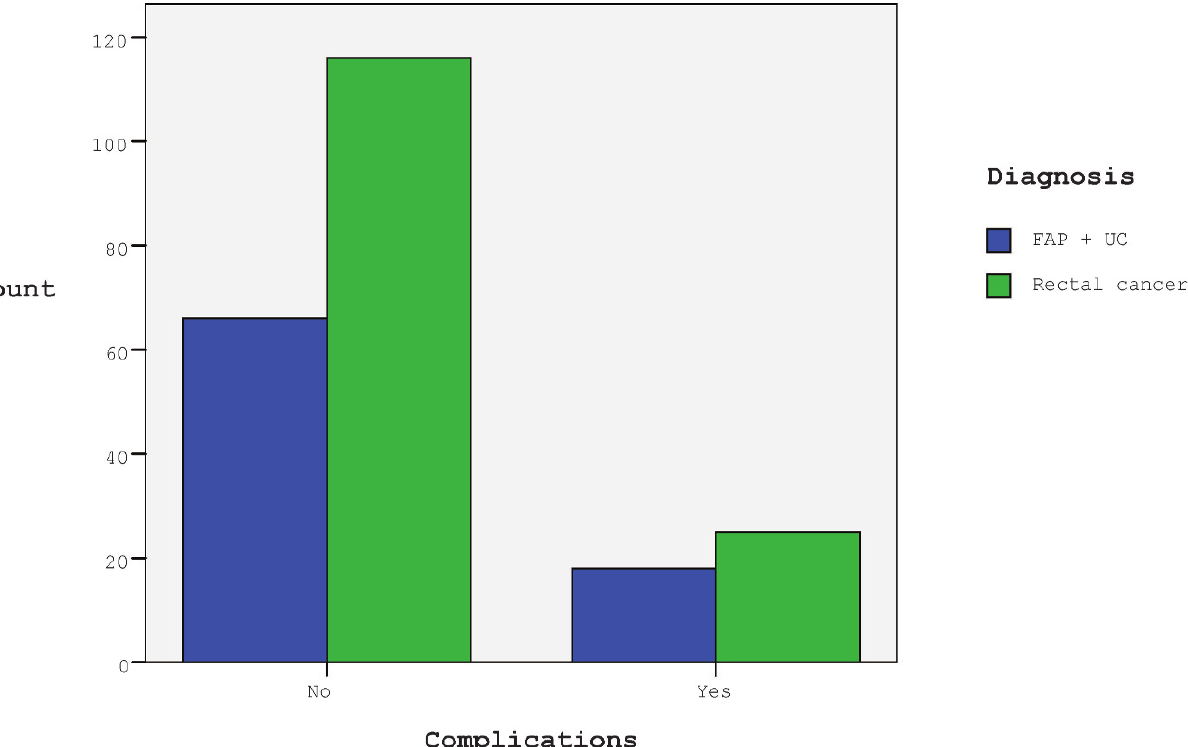
Figure 2 - A statistical analysis of the overall postoperative complications according to the initial diagnoses and the primary surgical